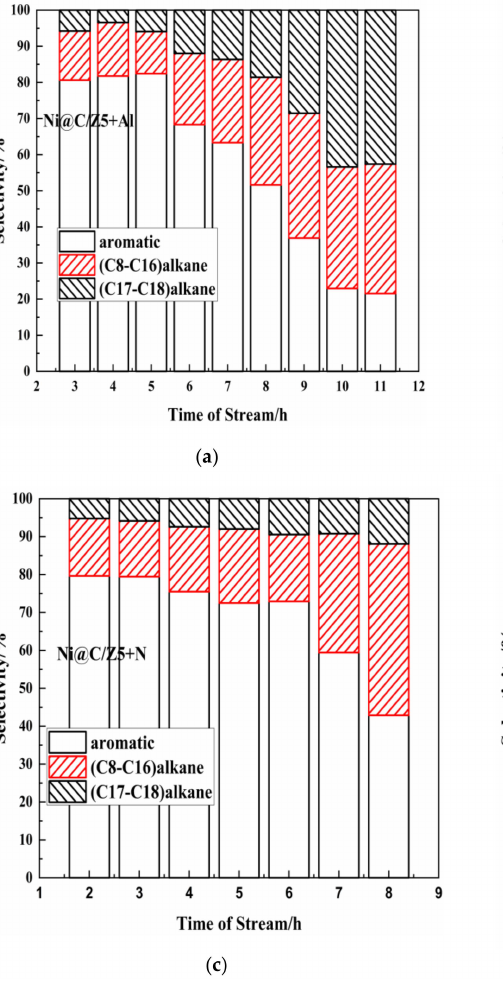
Figure 5. Product analysis of catalysts ( a ) Ni@C/Z5+Al, ( b ) Ni@C/Z5+Zr, ( c ) Ni@C/Z5+N, and ( d )